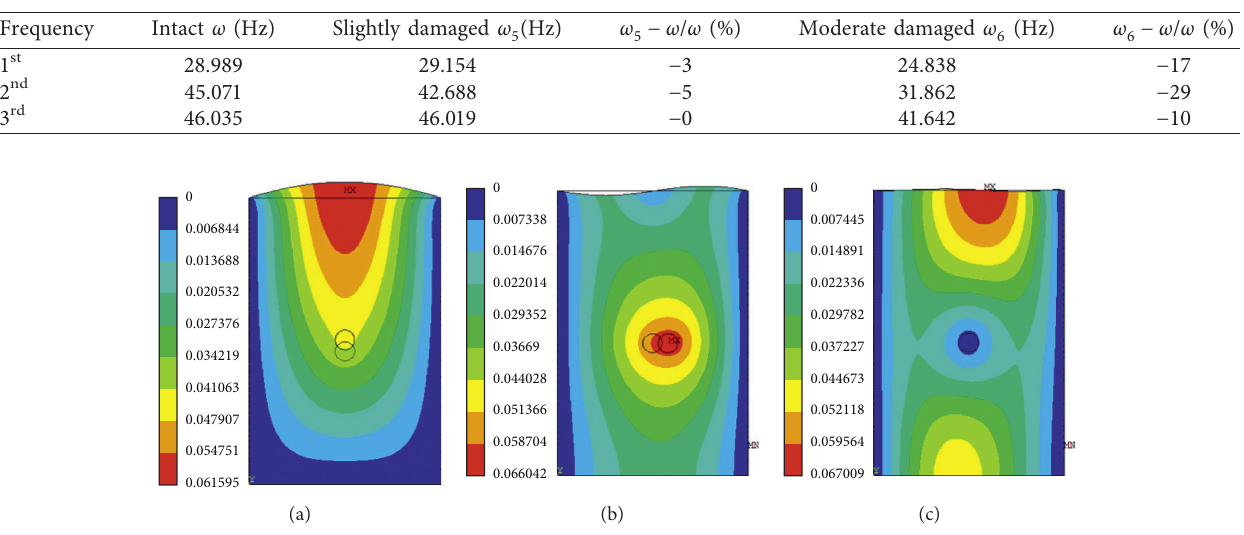
Figure 5: Shapes of the first three modes of the moderately vertically damaged polymer cutoff wall. (a) First vibration mode. (b) Second vibration mode. (c) Third vibration mode. Table 4: First 3-order natural frequencies of polymer cutoff wall with damage in the middle part.